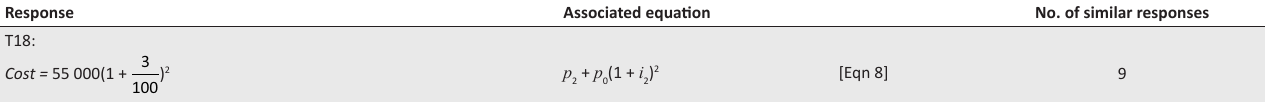
TABLE 2: Response of T18. Response